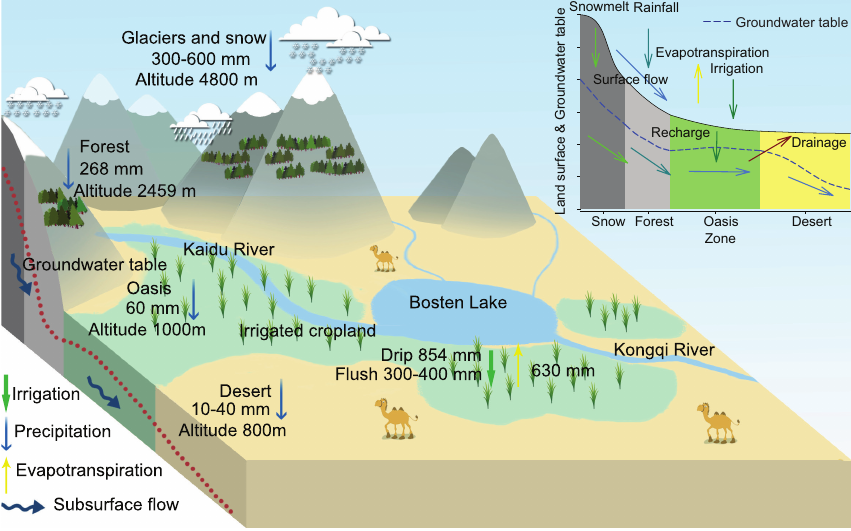
Figure 2. Sketch of hydrologic cycle in Kaidu–Kongqi River